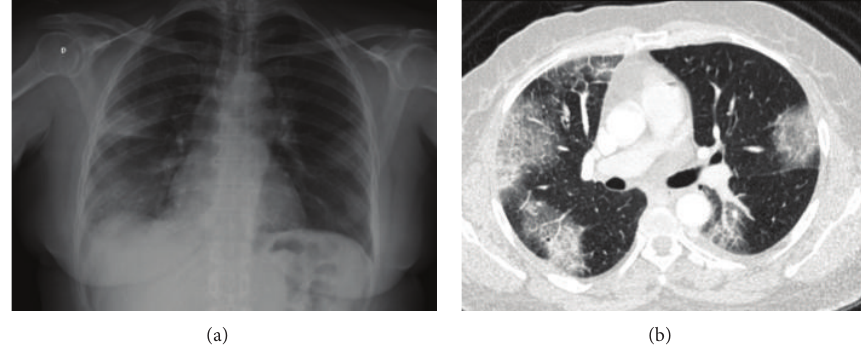
Figure 5: Chest X-ray and tomography : chest X-ray revealed ill-defined opacities in both lungs, especially in the middle and inferior field of the right lung (a). There was no mediastinal enlargement, a remarkable sarcoidosis radiographic sign. Axial high-resolution computer tomography(HRCT)scanrevealedmultipleground-grassopacitiesinbilateralsubpleuralareas,associatedwithinterlobularseptalthickening